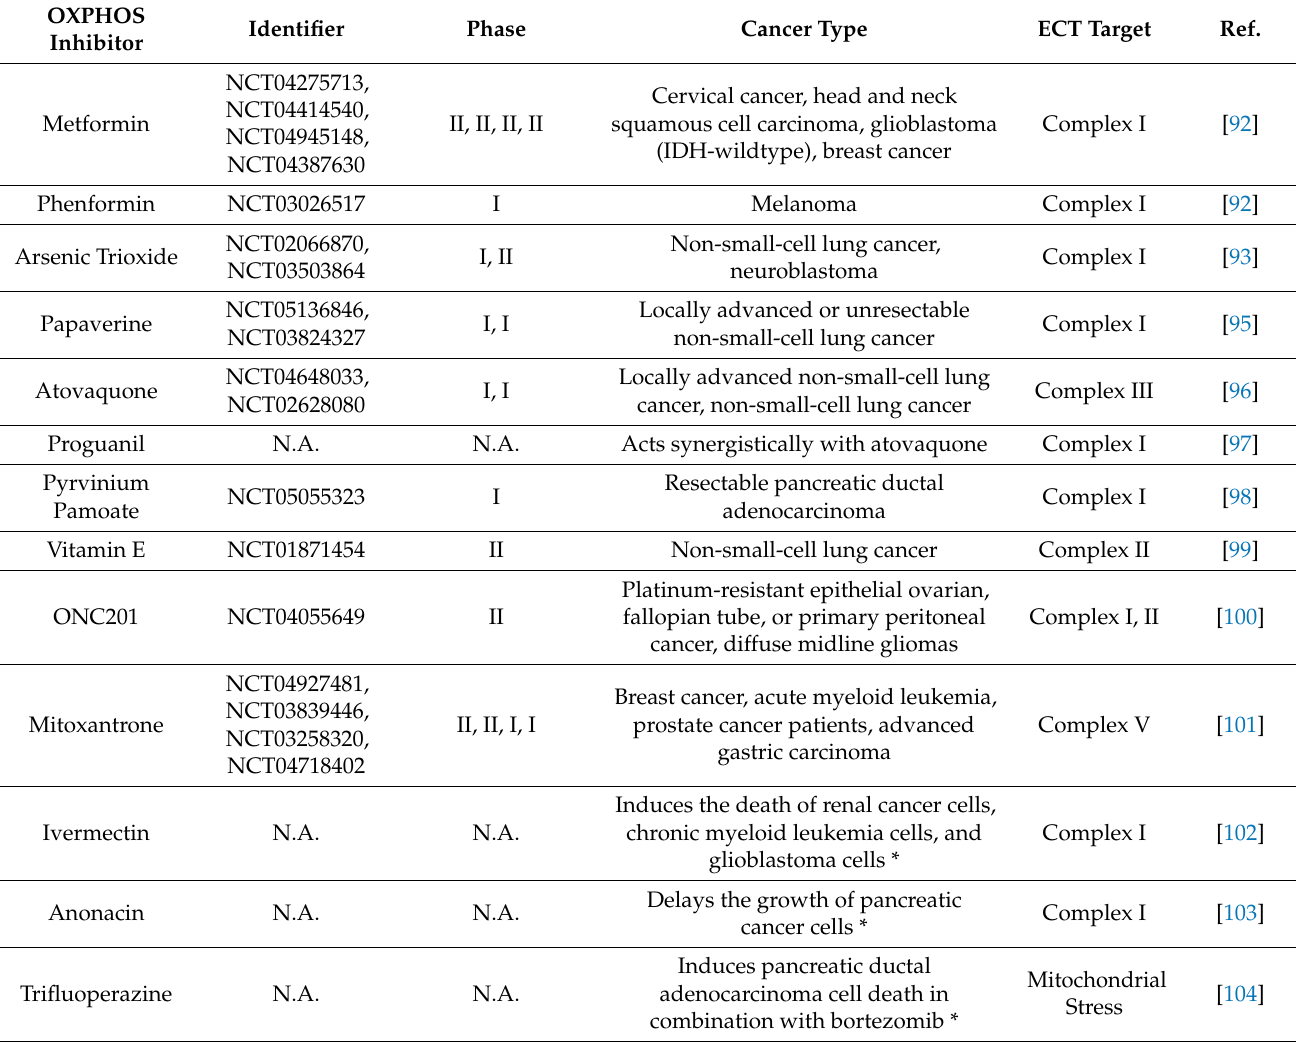
Table 1. List of OXPHOS inhibitors under clinical trials or